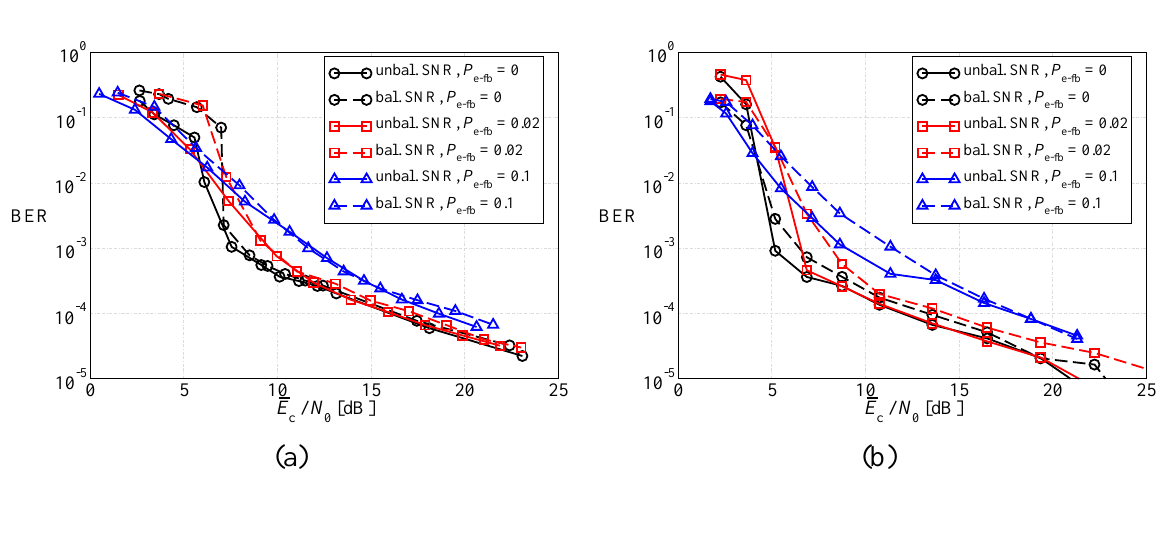
Figure 11. Average BER, as a function of the average SNR at the sources, in a scenario with noisy feedback channels, considering: (a) DD LDPC-coded schemes and (b) SCCCed schemes. Two possible values for P are considered: (i) 0.02 and (ii) 0.1. e − fb